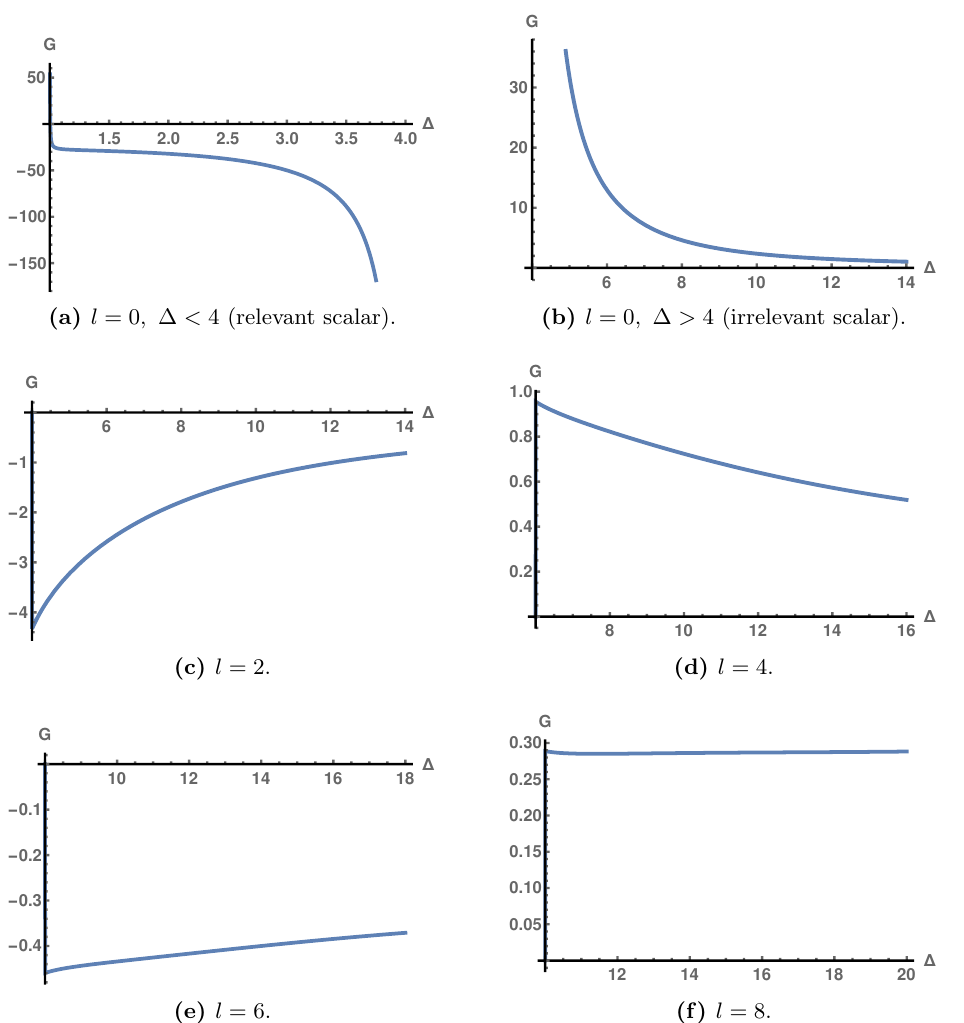
Figure 2. Integrated conformal blocks G as a function of operator dimensions for l = 0 ; 2 ; 4 ; 6 ; 8 spin in d = 4